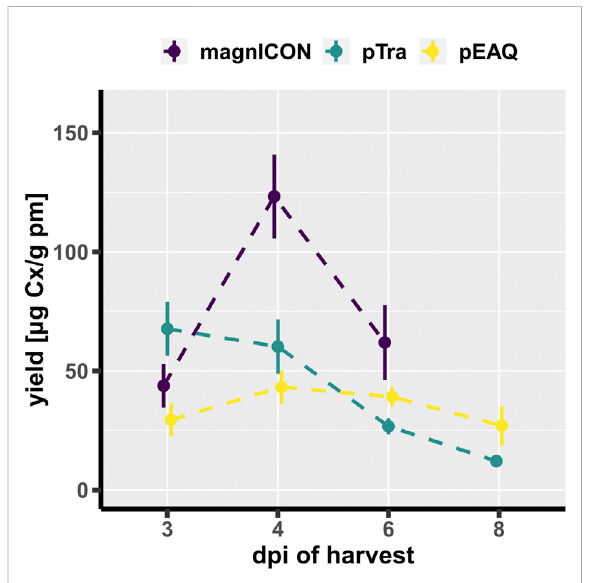
FIGURE 2 YieldofCxatdifferentdayspostin fi ltration(dpi),performedin triplicates. Error bars represent standard error ofthe mean. Yield in µg puri fi ed Cx per g plant material